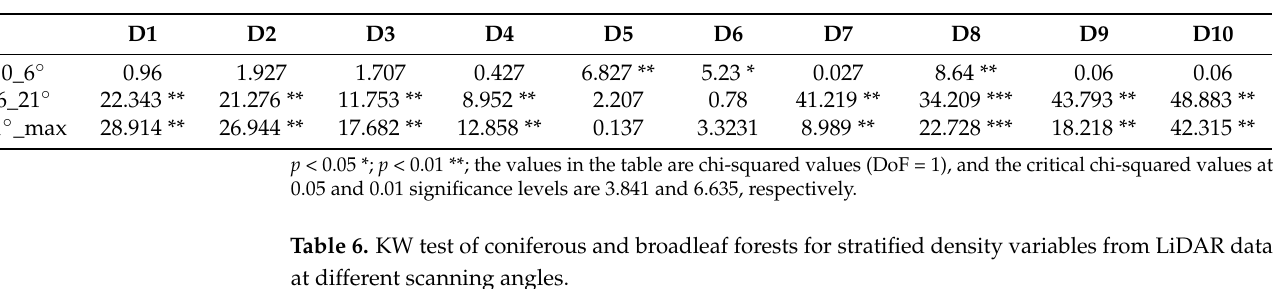
Table 5. KW test of coniferous and broadleaf forests for stratified density variables from LiDAR data at different scanning angles.